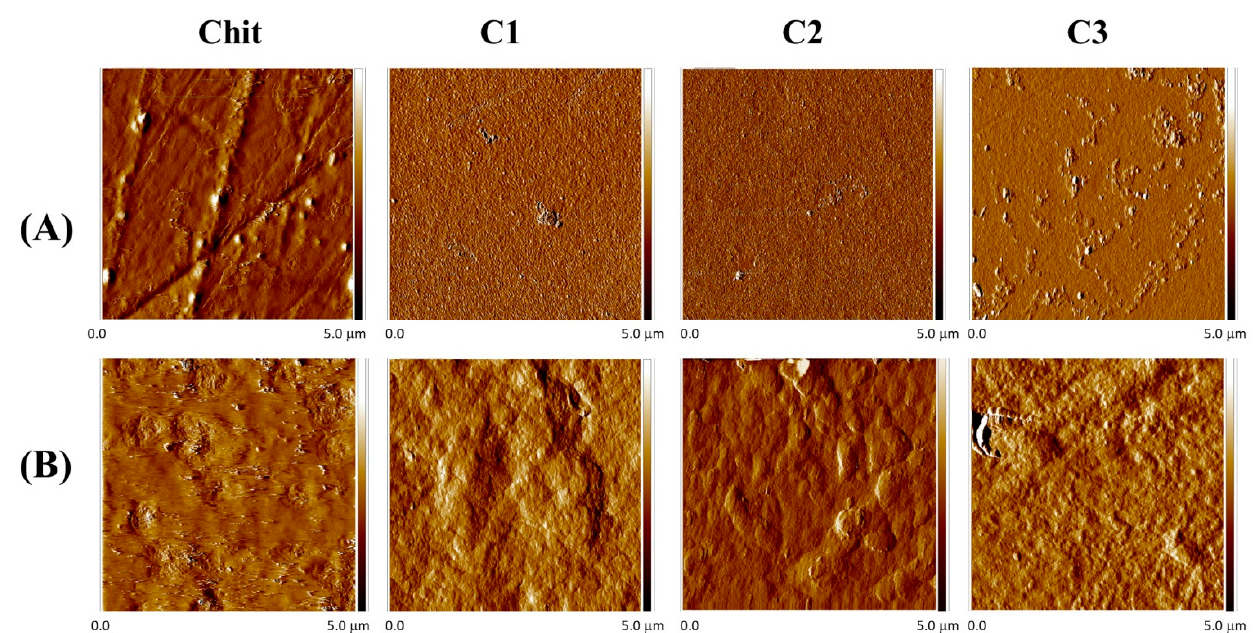
Figure 5. Representative AFM images of film surface of different composition ( A ) before and ( B ) after NaOH treatment. Table 3. Roughness parameters of films with various compositions before and after NaOH treat- ment.